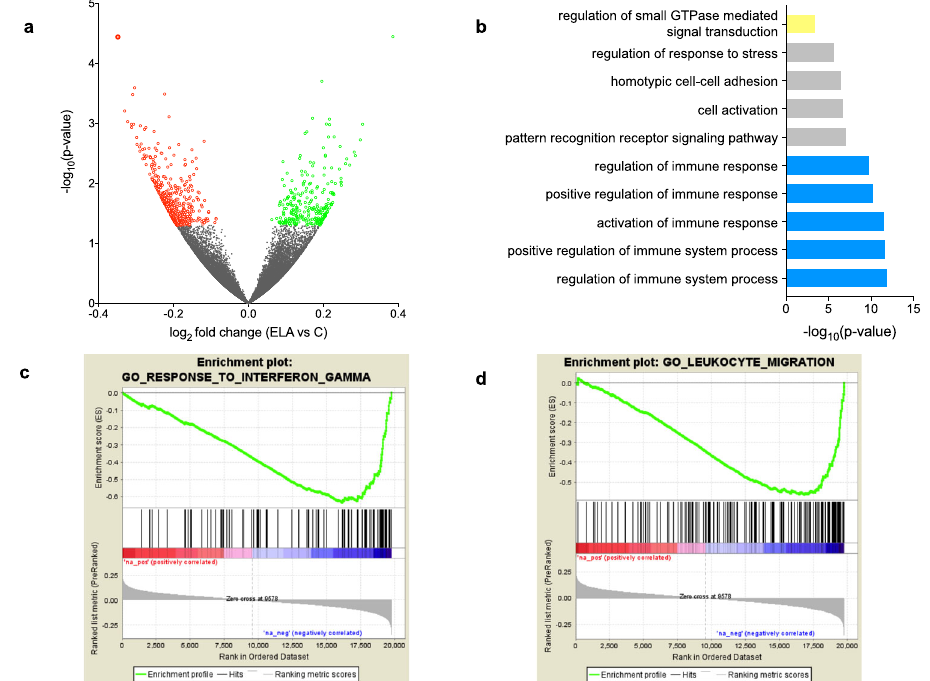
Fig. 7 Differential gene expression in subjects with a history of early-life adversity (ELA). a Volcano plot of RNA-Seq data showing the 261 and 474 genes that were up- (green circles) or downregulated (red circles) in the ELA group compared with the control (C) group (GLM model using gender, age, pH, PMI, and RIN as covariates; nominal P value < 0.05). b Gene Ontology analysis of the 735 differentially expressed genes in the ELA group. Terms showing evidence of enrichment for differential methylation, histone pro fi le or chromatin state are shown in yellow (small GTPase) or blue (immune processes; see also Supplementary Fig. 16f). c , d Gene Set Enrichment Analysis (GSEA) of gene expression changes in ELA subjects. Genes were ranked based on log 2 fold changes from the C versus ELA differential expression analysis ( “ Ranked list metric ” , in grey in the lower portion of each panel). Genes with the highest positive fold changes (in red, upregulated in the ELA group) are at the extreme left of the distribution, and those with the lowest negative fold changes (in blue, downregulated in the ELA group) are at the extreme right. A running enrichment score (green line, the upper portion of each panel) was computed for gene sets from the MSigDB curated molecular signatures database and used to identify enriched gene sets 42 . Among the numerous gene sets related to the immune function that showed evidence of genome-wide signi fi cant negative correlation with ELA (see main text, and Supplementary Table 14), two representative gene sets are shown (with the middle portion of each panel showing vertical black lines where members of the gene set appear in the ranked list of genes): c “ Interferon-gamma ” , and d “ Leukocyte migration ” . Of note, an oligodendrocyte-speci fi c gene collection, which we recently found downregulated in the anterior cingulate cortex of subjects with a history of ELA 40 , positively correlated with ELA in the amygdala (see Supplementary Fig. 16d), suggesting opposite adaptations in this glial population between cortical and subcortical structures. Source data are provided as a Source Data fi